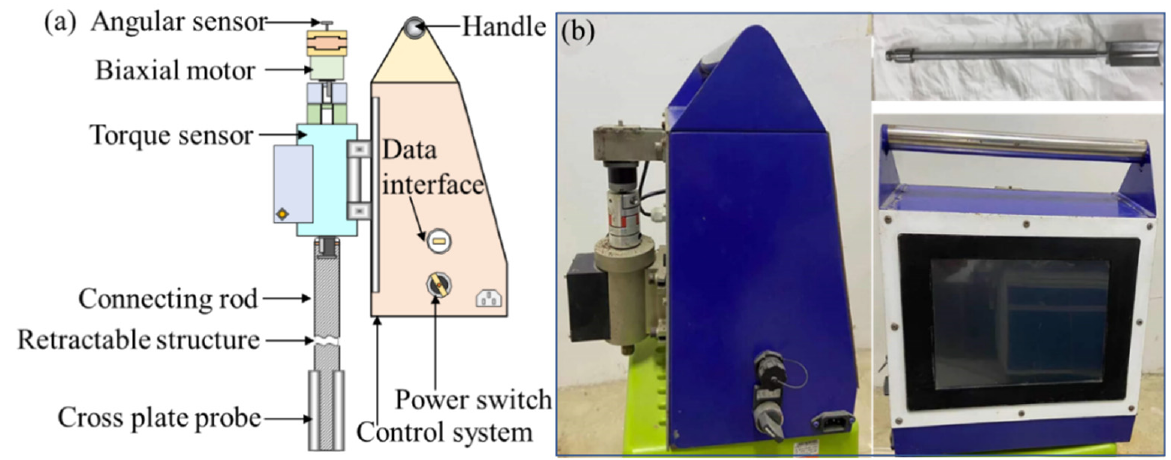
Figure 1. ( a ) Design schematic of the in situ device. ( b ) Photo of the in situ device. Clockwise from top left: whole body of the device; the cross plate probe; the display screen.